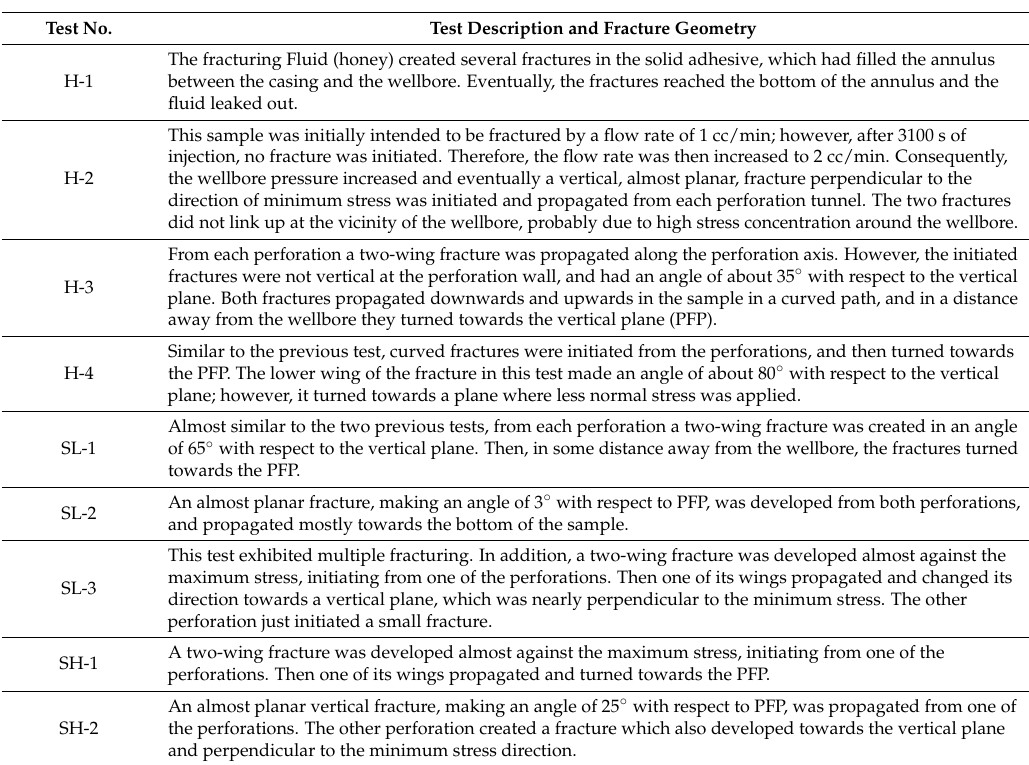
Table 5. Brief description of the fracture